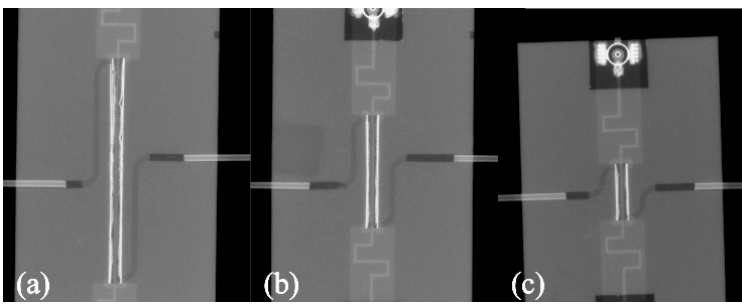
Figure 5. X-ray images of ( a ) 20 mm, ( b ) 10 mm, and ( c ) 5 mm long microreactor.